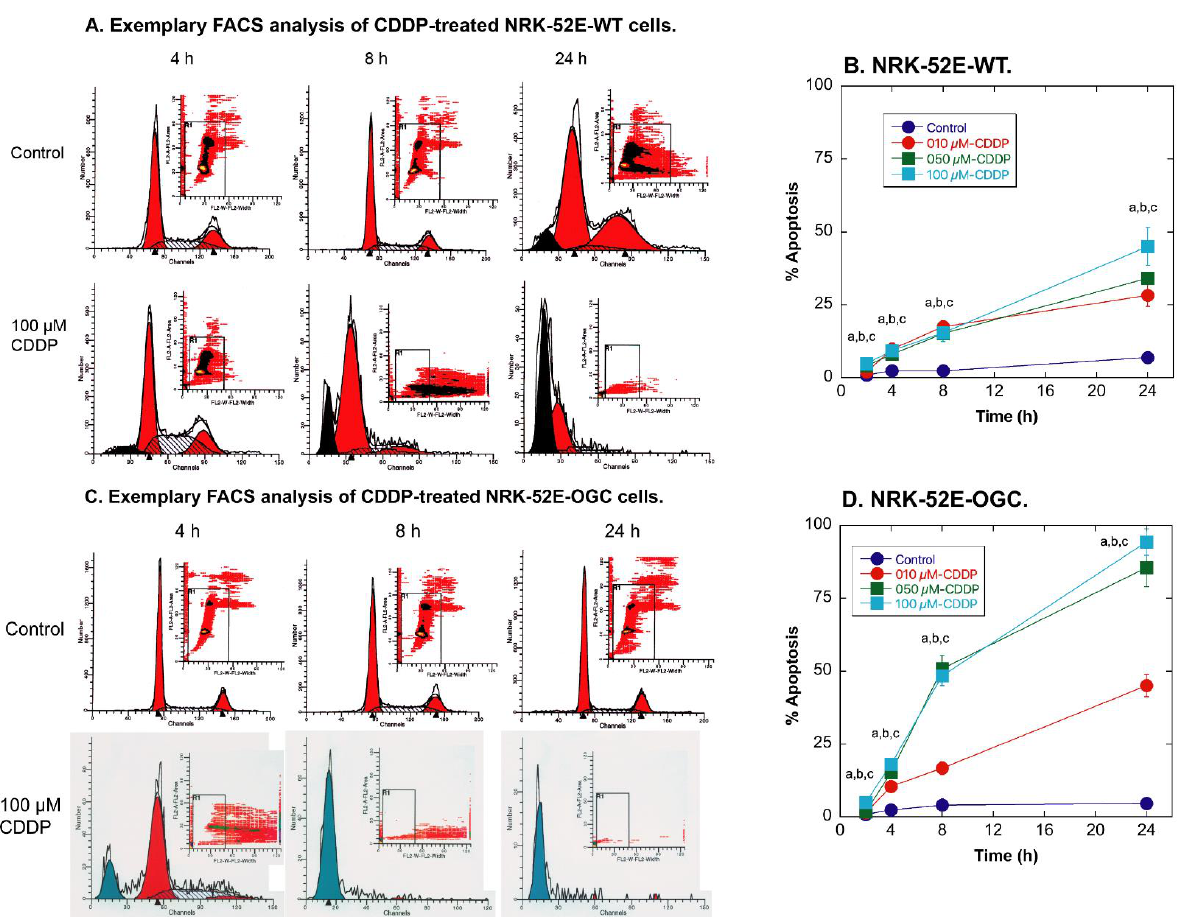
Figure 2. Time and concentration dependence of CDDP-induced cell cycle changes. Confluent, wild- type NRK-52E cells (NRK-52E-WT) and confluent, NRK-52E cells stably overexpressing OGC (NRK-52E-OGC) were preincubated for 24 h on 35-mm dishes with media containing 1 mM GSH and were then incubated for up to 24 h with either media (= 0 µM) containing 20 µM GSH or media containing 10, 50, or 100 µM CDDP in the presence of 20 µM GSH. Cells were harvested by tryp- sin/EDTA treatment, washed in sterile PBS, fixed overnight in ethanol, and then stained with pro- pidium iodide and analyzed by flow cytometry with a Becton Dickinson FACS Calibur flow cytom- eter. ( A ) Exemplary FACS analysis of NRK-52E-WT cells treated with 100 µM CDDP. ( B ) Time- and concentration-dependent apoptosis induced by CDDP in NRK-52E-WT cells. ( C ) Exemplary FACS analysis of NRK-52E-OGC cells treated with 100 µM CDDP. ( D ) Time- and concentration-depend- ent apoptosis induced by CDDP in NRK-52E-OGC cells. For panels B and D, a,b,c = Significantly different ( p < 0.05) from 0-µM control for 10, 50, and 100 µM CDDP, respectively, at the same time point.